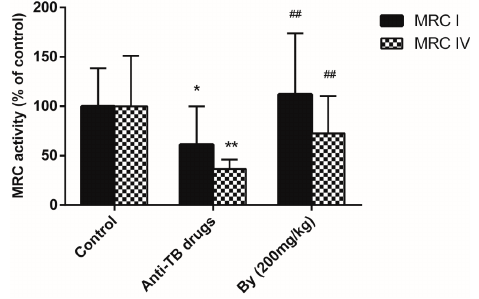
Figure 5. Effect of bicyclol on the activity of liver mitochondrial MRC I and MRC IV in anti-TB drug intoxicated rats. Bicyclol (200 mg/kg) was administered orally to rats for 30 days. Data were expressed as means ± SD ( n = 10). *, p < 0.05, **, p < 0.01 vs. control group; ## , p < 0.01 vs. anti-TB drug intoxicated